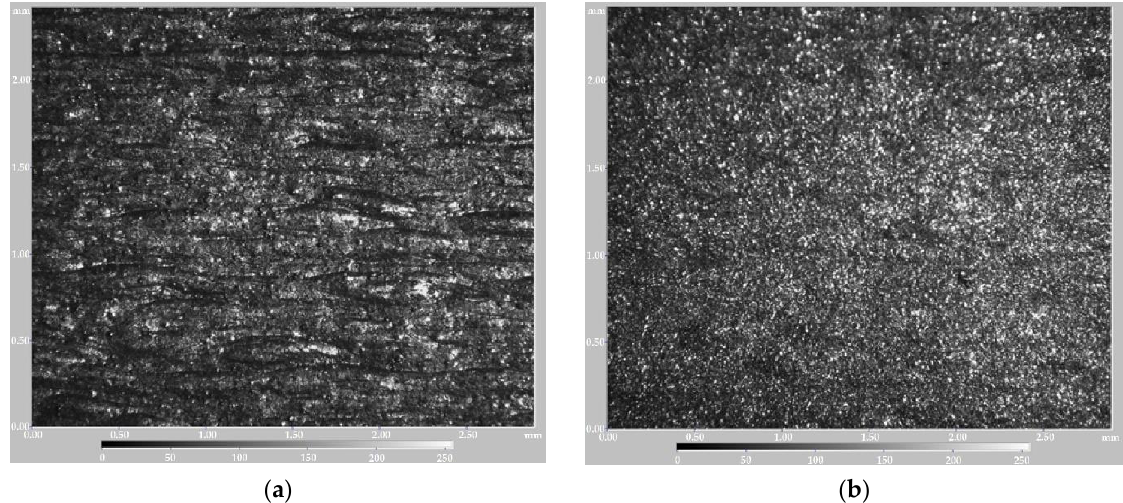
Figure 3. Topology of the laser additively produced part surface made of 12Cr18Ni9Ti austenite chrome–nickel stainless steel (analog of AISI 321) powder with granules of ≈20 µm (by a Dektak XT stylus profilometer (Bruker Nano, Inc., Billerica, MA, USA) with a vertical accuracy of 5 Å (0.5 nm) and a tip radius of 12.5 µm): ( a ) after production; ( b ) after vibratory tumbling.